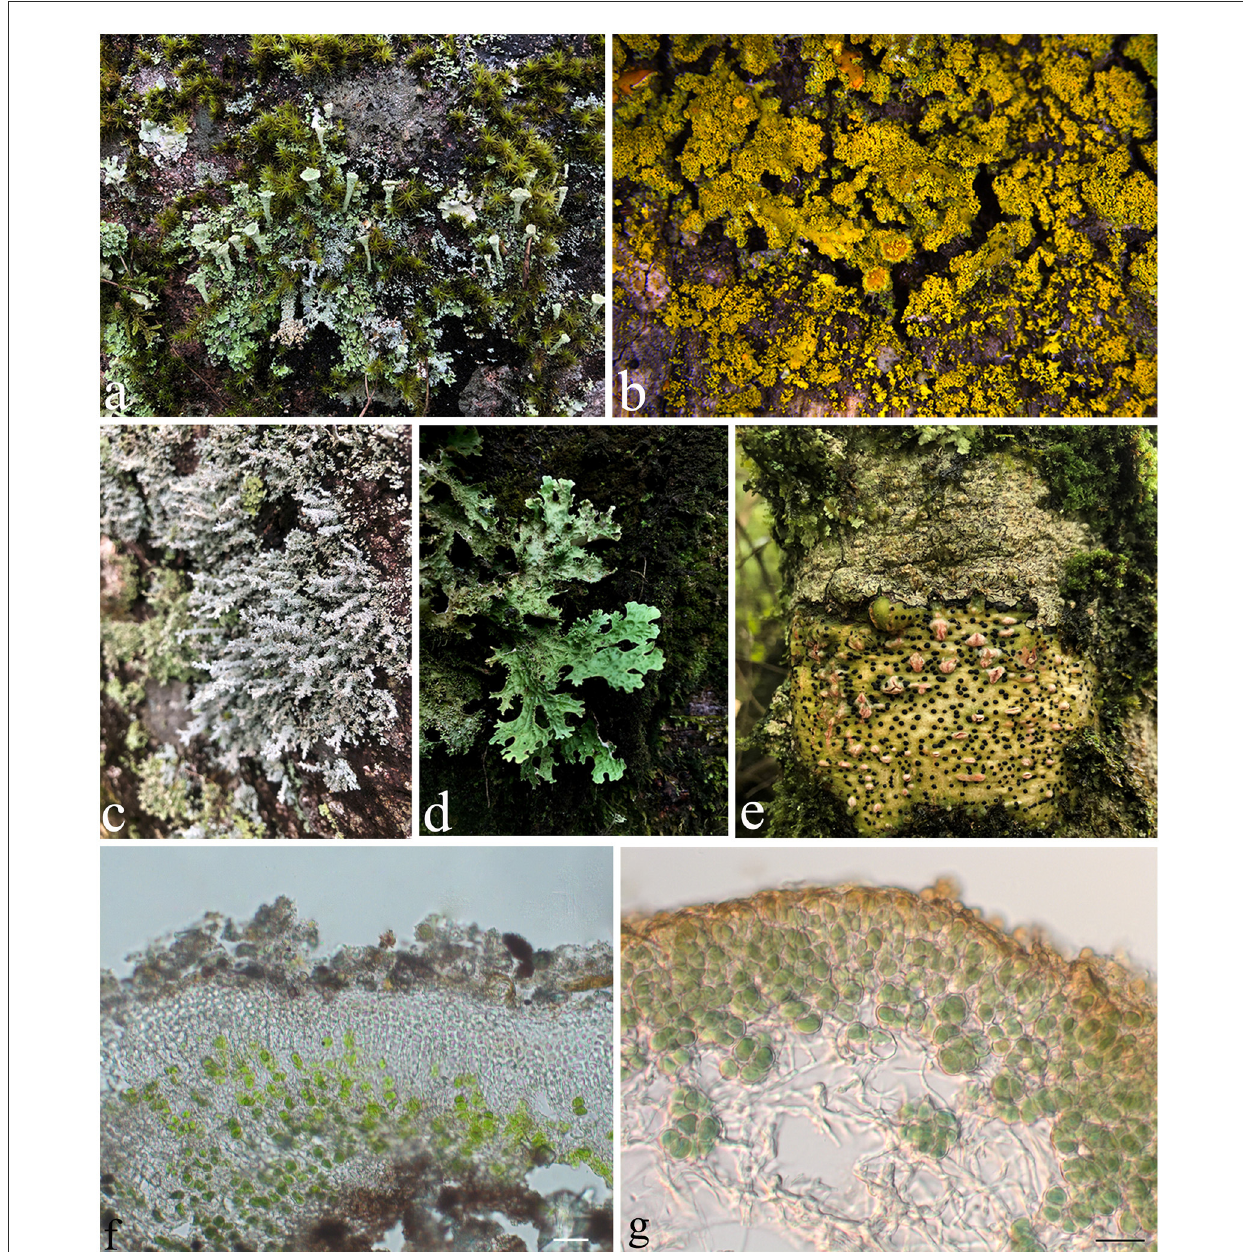
FIGURE1 The diversity of lichens. (a) Cladonia sp.; (b) Candelaria sp.; (c) Stereocaulon sp.; (d) Sticta sp.; (e) Pyrenula sp.; (f) Thallus of Endocarpon pallidulum in vertical section, with green algae Diplosphaera chodatii as the photobiont; (g) Thallus of Peltula submarginata in vertical section, with cyanobacteria Chroococcales as the photobiont. Photos (b, f) were taken by Xue XD and Zhang TT, respectively, and photos (a, c–e) were taken by Yang QX. Scale bars: (f) = 20 µ m, (g) = 10 µ